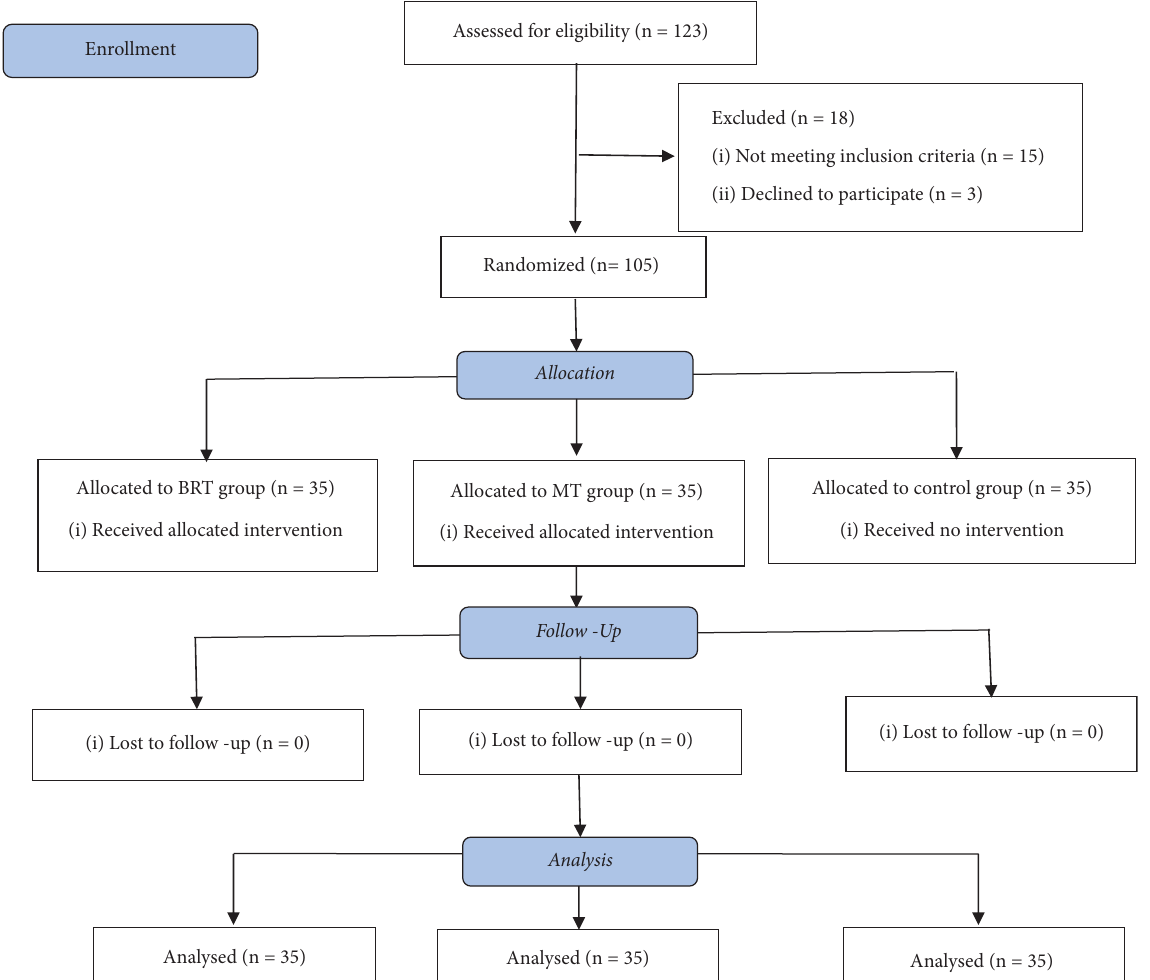
Figure 1: Te process of the study is according to the CONSORT fow diagram